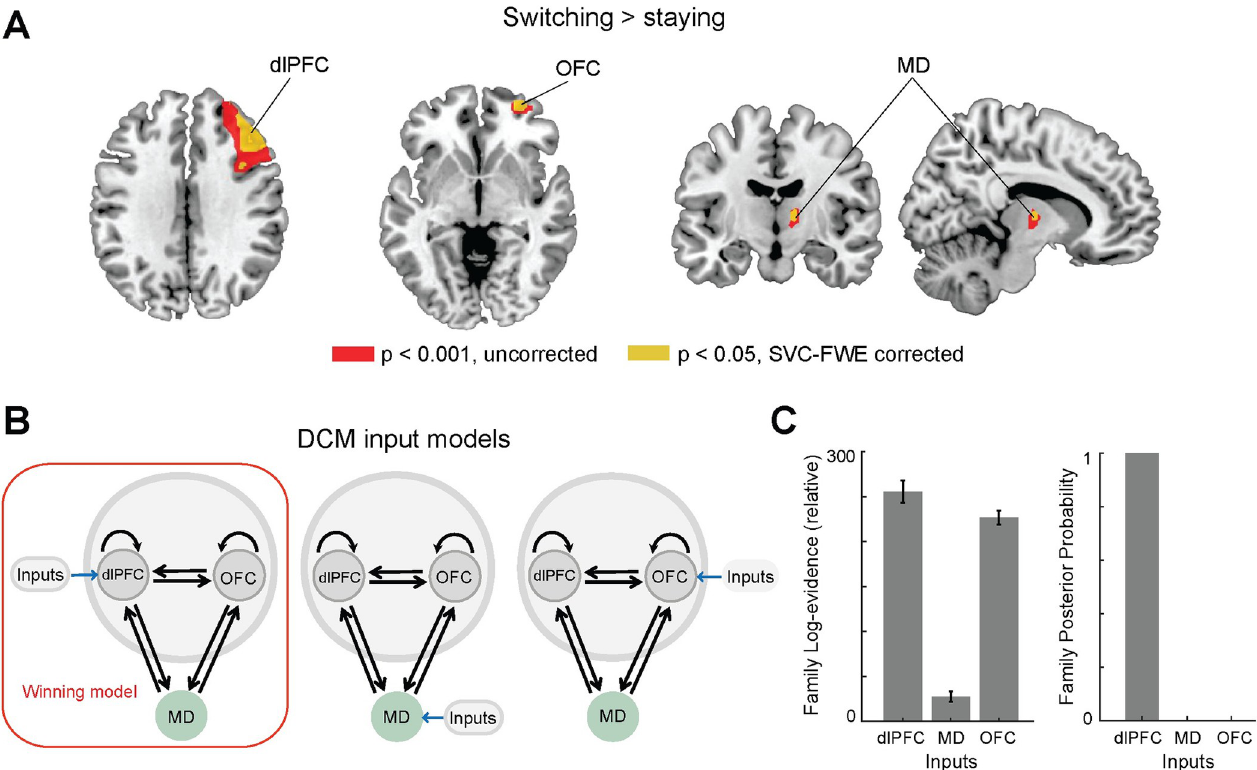
Fig 2. Human fMRI confirms the dlPFC, not OFC or MD, receives the driving sensory input. A. Strategy switching ( Switching > Staying) entailed significant activity in right dlPFC, right OFC and right MD; here projected on axial, coronal and sagittal MRI brain slices. Brain activations displayed at p < 0.001 (uncorrected, red) and p < 0.05 (whole brain FWE correction, yellow; small-volume correction, blue). B. Models with dlPFC, MD and OFC receiving sensory tactile driving “inputs” respectively. C. Bayesian Model Selection revealed dlPFC, not OFC or MD, as the input region. The left panel shows the average and standard error of log-evidence for all models in the corresponding inputs family (we have 6 models for each input family, see S5 Fig). The sum of the log- evidence over subjects was used to compute the expected model posterior probabilities of each input family which are shown in right panel. (dlPFC– dorsolateral prefrontal cortex; OFC–orbitofrontal cortex; MD–thalamic mediodorsal nucleus).